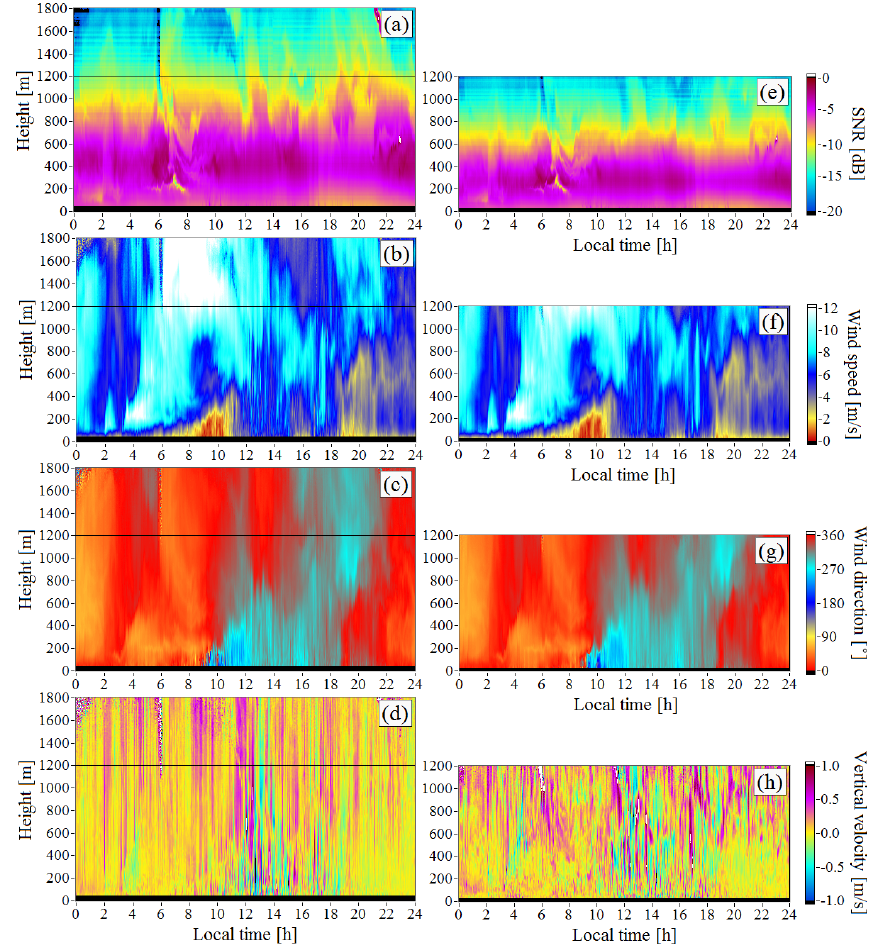
Figure 1. Height–temporal distributions of the signal-to-noise ratio (a, e) , wind speed (b, f) , wind direction angle (c, g) , and vertical compo- nent of the wind vector (d, h) for elevation angles of 60 ◦ (a–d) and 35.3 ◦ (e–h) on 21 July